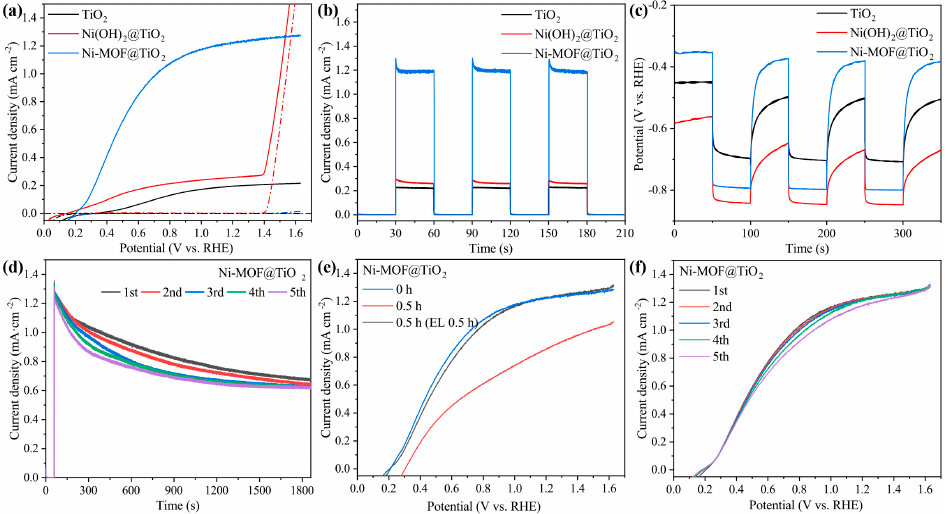
Figure 2. ( a ) LSV curves of TiO 2 , Ni(OH) 2 @TiO 2 , and T-Ni(OH) 2 @TiO 2 in 1 M KOH/0.33 M urea at a scan rate of 20 mV s − 1 . Dash line: dark. Solid line: AM1.5G illumination. ( b ) Chopped j-t curves of TiO 2 -based photoanodes at 1.23 V RHE . ( c ) OCP of TiO 2 -based photoanodes under the chopped light. ( d ) Stability test of T-Ni(OH) 2 @TiO 2 in 1 M KOH/0.33 M urea at 1.23 V RHE . ( e ) LSV curves of T-Ni(OH) 2 @TiO 2 before and after 0.5 h stability test and 0.5 h EL treatment. ( f ) LSV curves of T-Ni(OH) 2 @TiO 2 before each cycle of the stability test and EL treatment.